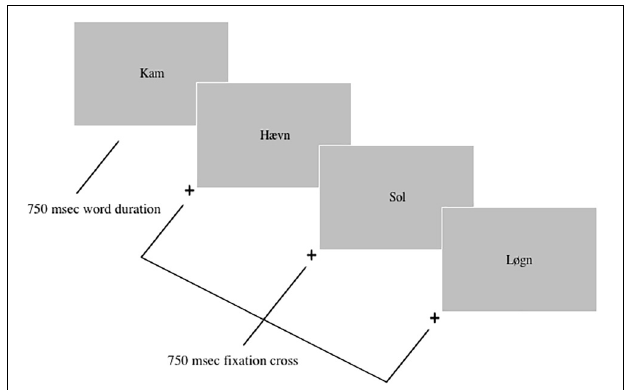
FIGURE 1 | Illustration of the Verbal Affective Memory Test-26. Each word trial displayed a fixation cross (750 ms) and a word (750 ms) in black (font = Times, size = 40) on a gray background. The Danish [English] words presented in the figure are: Kam [comb], Haevn [revenge], Sol [sun], Løgn